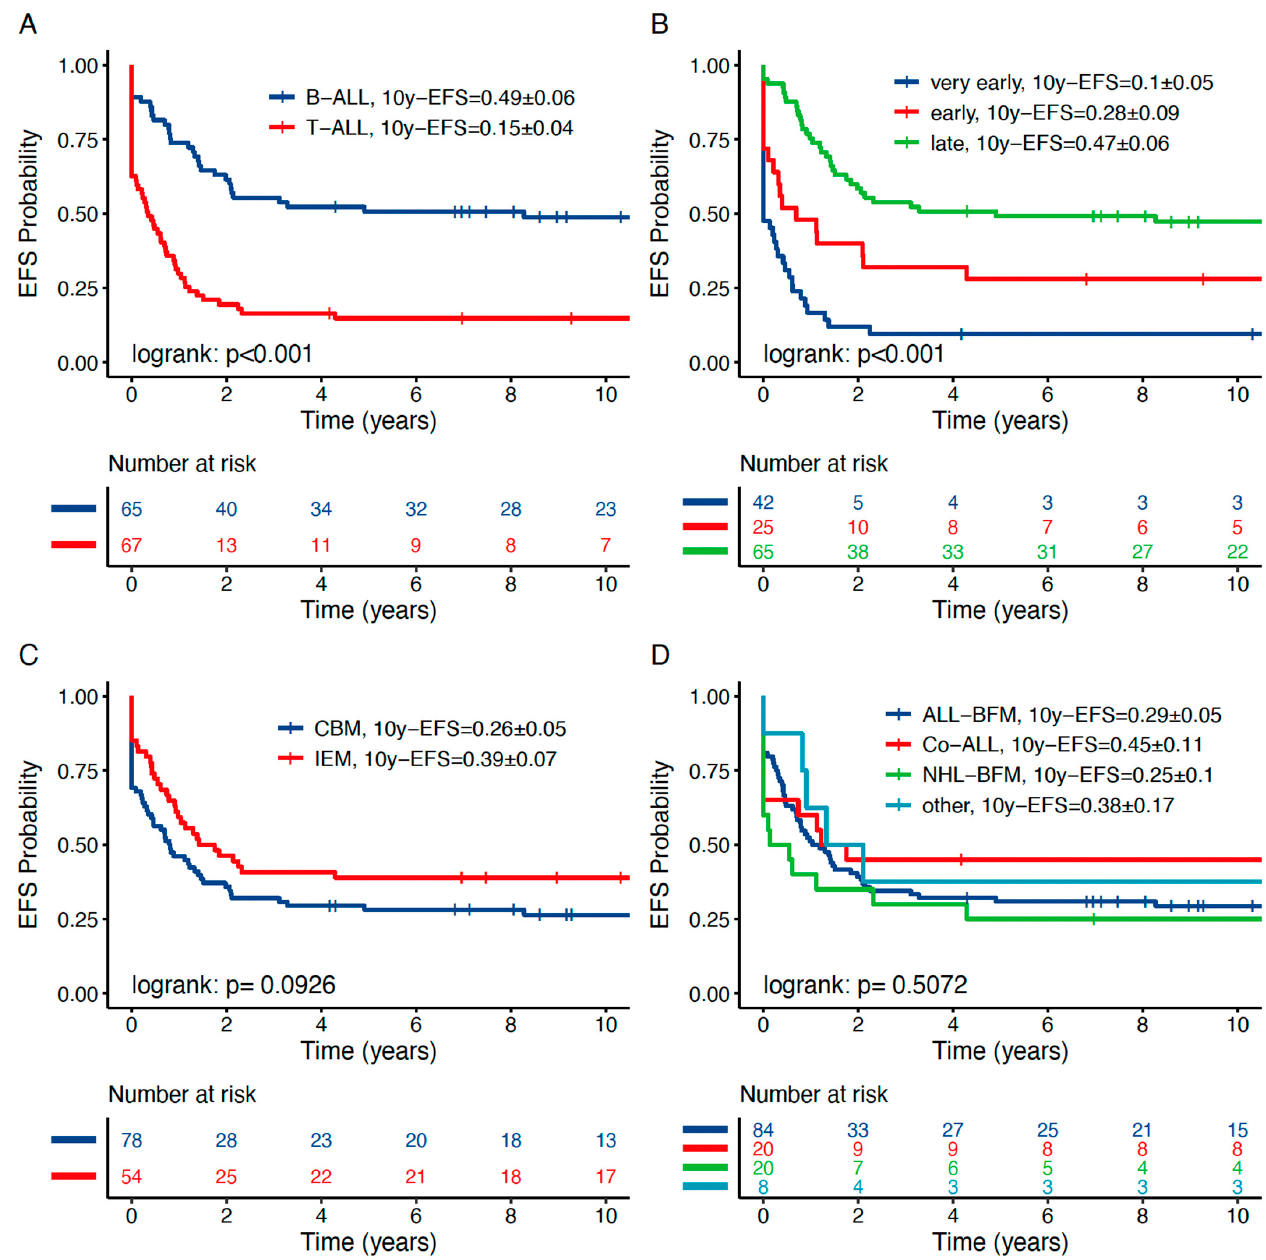
Figure 3. Ten-year pEFS ( A – D ) of OEMR patients in defined demographic subgroups. ( A ) T-ALL, ( B ) very early relapse and ( C ) combined BM relapse are correlated with significantly decreased 10-year pEFS. ( D ) Previous treatment protocol is not associated with outcome in OEMR patients. Calculation based on Kaplan–Meier analysis. p < 0.05.